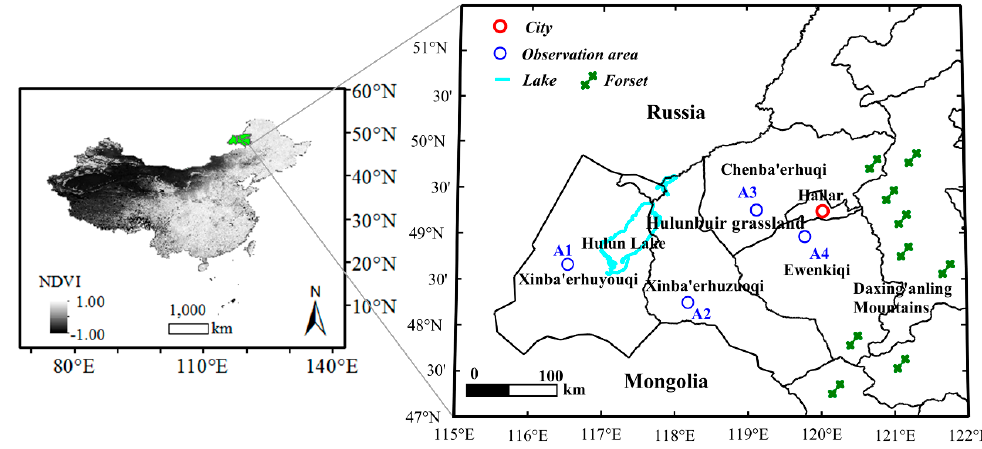
Figure 1 . Location of study region. Figure 1. Location of study region.